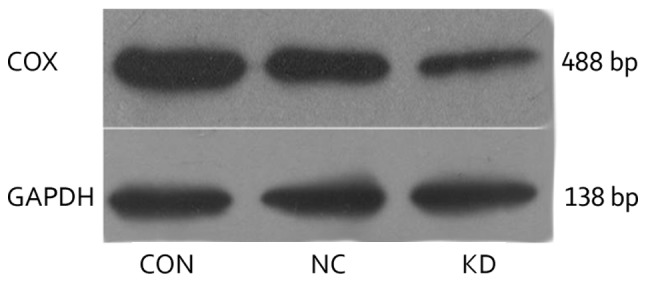
Cyclooxygenase-2 mRNA expression analysis following quantitative polymerase chain reaction. COX, cyclooxygenase; CON, control; NC, negative control; KD, interference group; bp, base pairs.